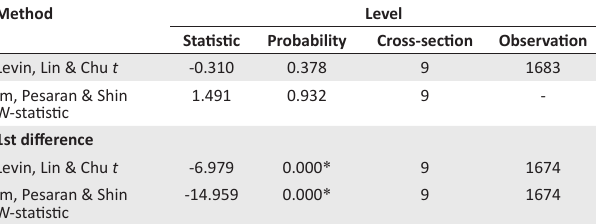
TABLE 1: Panel unit root test: Exports. Method Level Statistic